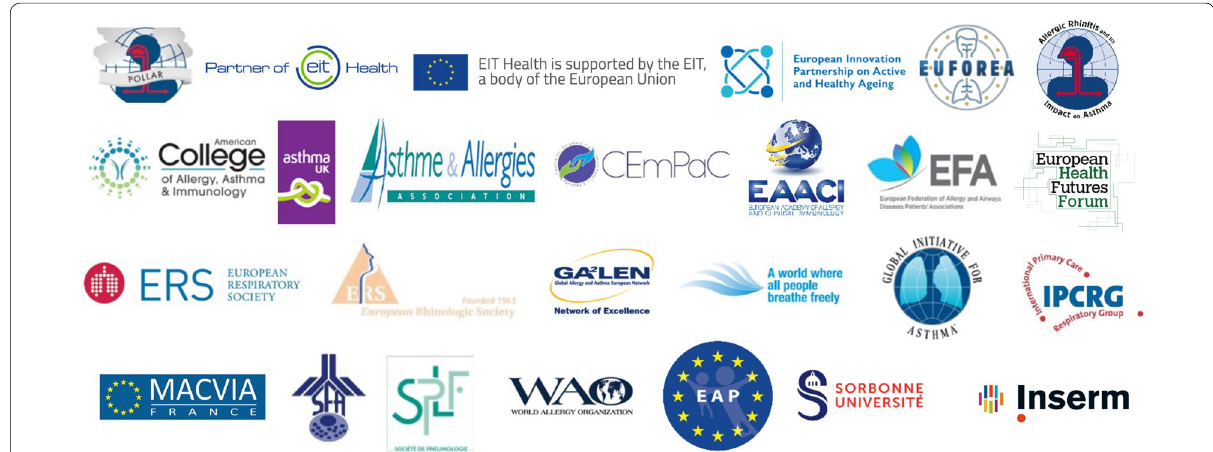
Fig. 7 Sponsors of the meeting (Paris, December 3, 2018). POLLAR: Impact of Air POLLution in Asthma and Rhinitis, EIT Health: European Institute for Innovation and Technology, ARIA: Allergic Rhinitis and its Impact on Asthma, Euforea: European Forum for Research and Education in Allergy and Airways Diseases GA2LEN: Global Allergy and Asthma European Network, CEmPac: Centre for Empowering Patients and Communities, EAACI: European Academy of Allergy and Clinical Immunology, EFA: European Federation of Allergy and Airways Diseases Patients’ Associations, ERS: European Respiratory Society, ERS: European Rhinology Society, GARD: Global Alliance against Chronic Respiratory Diseases (WHO Alliance), GINA: Global Initiative for Asthma, MACVIA: Fondation VIA‑LR, SPLF: Societé de Pneumologie de Langue Française, SFA: Société française d’Allergologie, WAO: World Allergy